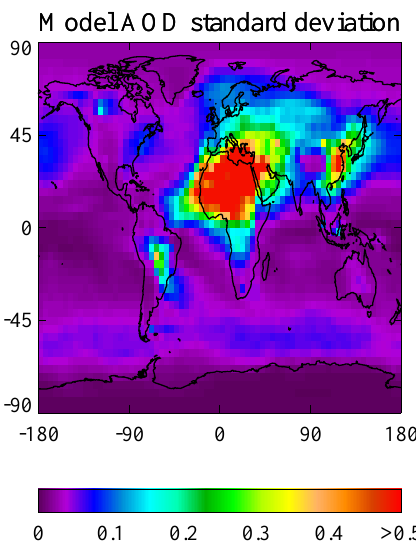
Fig. 2. Day-to-day standard deviation of GEOS-Chem AOD field. Fig. 3. Number of days during 2004 when a GEOS-Chem grid cell contains any successful AATSR aerosol